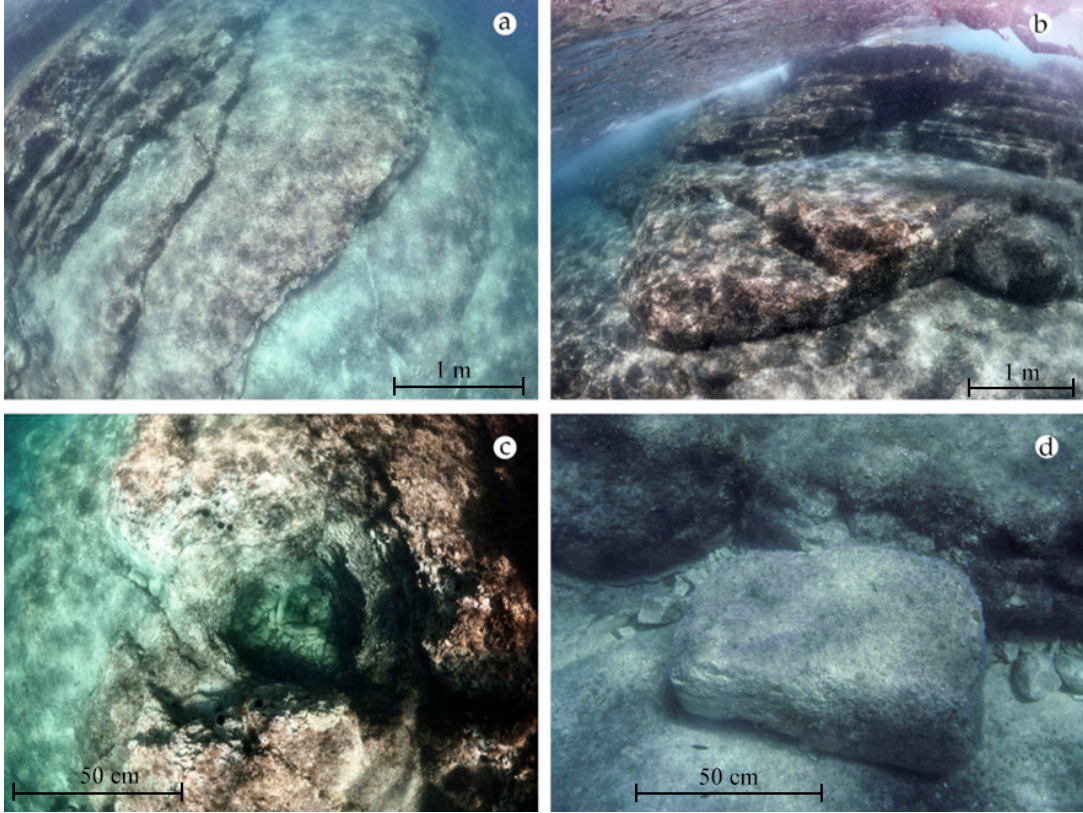
Figure 6. ( a ) Limestone beds below the mean sea level, ( b ) a detachment scar, ( c ) the largest pothole in the submerged area, and ( d ) isolated